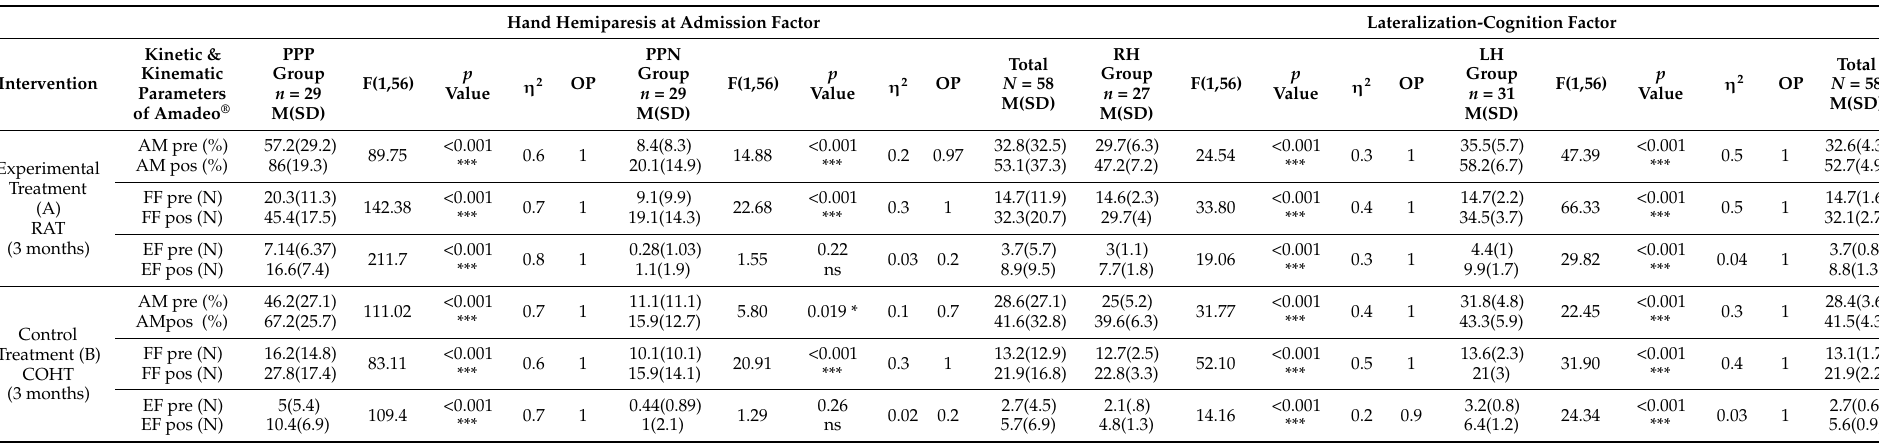
Table 1. Kinetic-kinematics effects of COHT and RAT treatments at 3 and 6 months by both prognosis (PPP, PPN) and lateralization-cognition groups (RH, LH). Hand Hemiparesis at Admission Factor Lateralization-Cognition